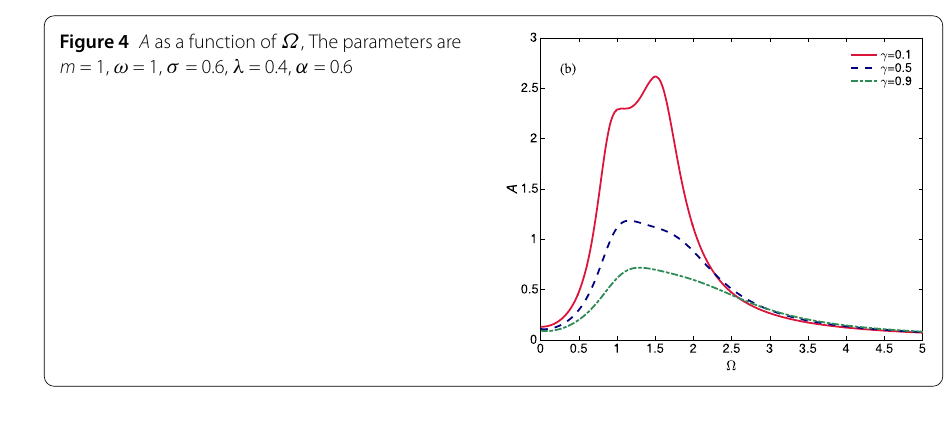
Figure 5 A as a function of σ 1 , The parameters are m = 1, γ = 0.2, ω = 1, Ω = 1.6, λ =